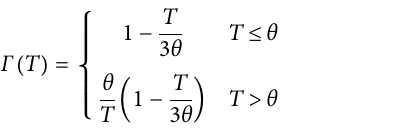
Frontiers in Earth Science |